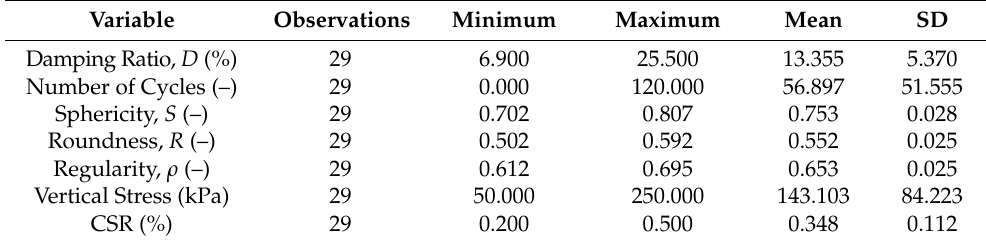
Table 4. Descriptive statistics for the training dataset.